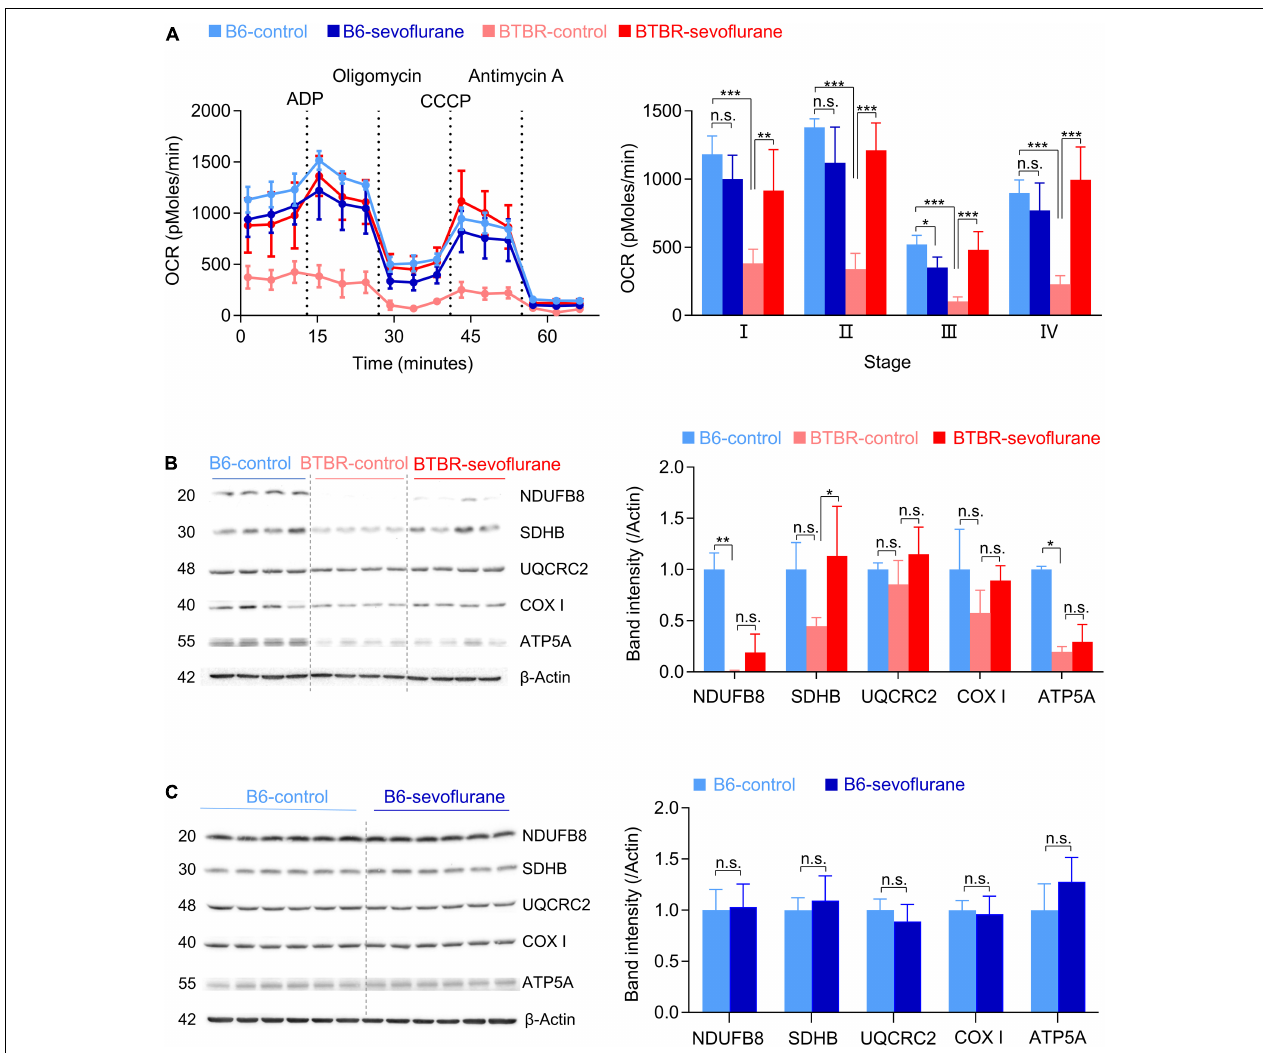
FIGURE 2 | Sevoflurane exposures induce a long-lasting increase in mitochondrial respiration in late postnatal BTBR mice. OCR and expression of mitochondrial complex subunits were measured from the cerebral cortex 5 days after sevoflurane exposures. (A) OCR measurements were obtained in five stages: I, basal stage OCR; II, OCR during ATP production, measured by adding ADP; III, OCR from protein leakage, measured by adding oligomycin; IV, uncoupled respiration, measured by adding CCCP; V, non-mitochondrial respiration, measured by adding antimycin A. Dotted lines indicate the time at which specific drugs were added. Average OCR (three measurements in every stage for each brain sample) was compared between groups. (B6-control, n = 5 mice; B6-sevoflurane, n = 5 mice; BTBR-control, n = 4 mice; BTBR-sevoflurane, n = 5 mice). (B,C) Western blot results of the five mitochondrial complex subunits. Numbers on the left of the images indicate protein size (kDa). (B) Protein expression levels were measured in B6-control, BTBR-control, and BTBR-sevoflurane mice ( n = 4 per group). (C) Protein expression levels were measured in B6-control and B6-sevoflurane mice ( n = 6 per group). Values are presented as mean ± SD (* p < 0.05, ** p < 0.01, *** p < 0.001, n.s., not